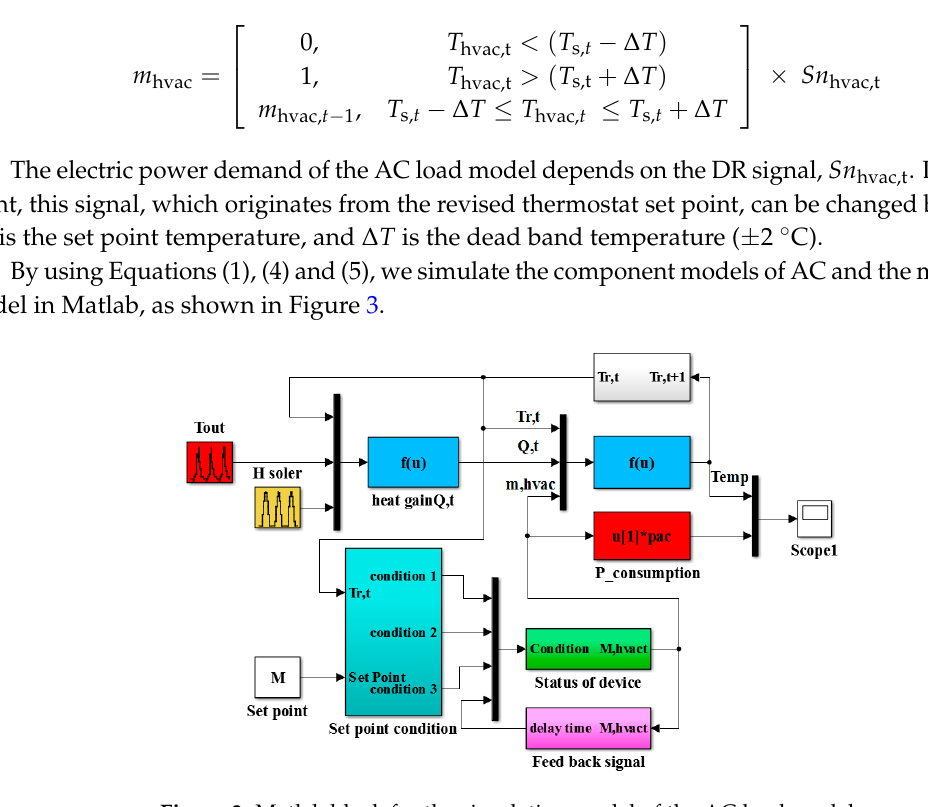
Figure 3. Matlab block for the simulation model of the AC load model.